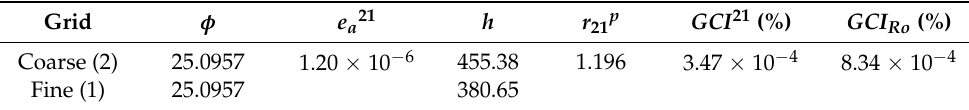
Table 2. Summary of results, high-pressure section.